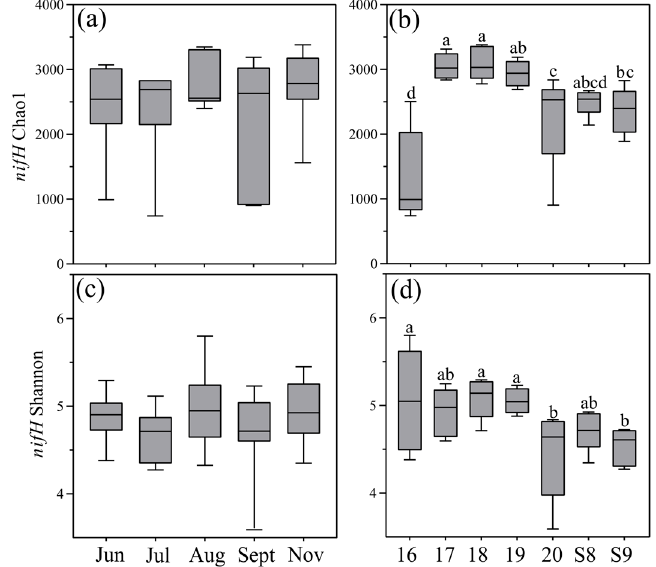
Figure 3. The variation of nitrogen fixation rates ( a , b ) and nifH gene abundance ( c , d ) among cruises and sampling sites in surface sediments from the Muping Marine Ranch. Different letters represent significant differences at p < 0.05 by ANOVA and LSD test in different cruises and sites.